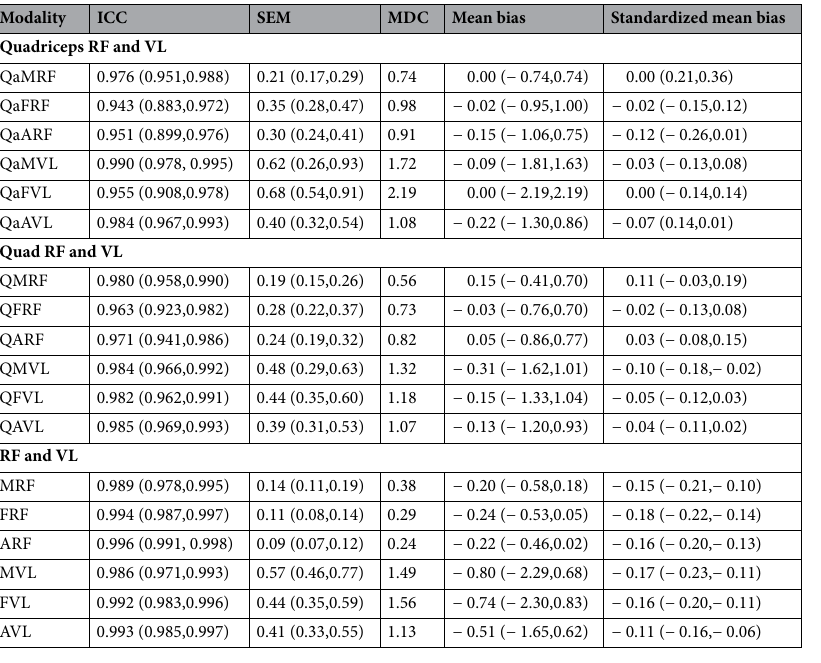
Table 3. Intra-class correlation (ICC) standard error of measurement (SEM) and standardized mean difference with 95% compatibility interval. Mean bias with limits of agreement set to ± 1.96 standard deviations and minimal detectable change (MDC). Values are displayed in cm 2 with standardized mean bias being displayed in SDs. All values calculated for m. rectus femoris (RF) and m. vastus lateralis (VL) comparing two measurements of investigator 1. “Manual” (M), “Fixed pixels” (F) and “Automatic” (A) outline-finder starting points. “Quadriceps” (Qa), “Quad” (Q) and separate image modes were